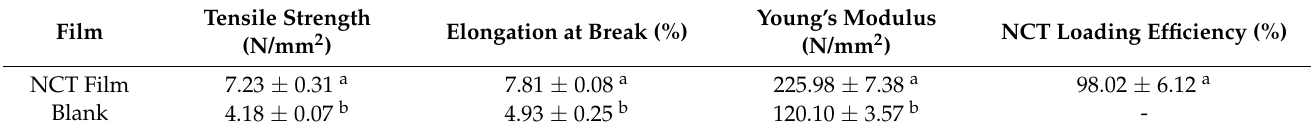
Table 3. Mechanical properties and NCT loading efficiency of NCT fast dissolving